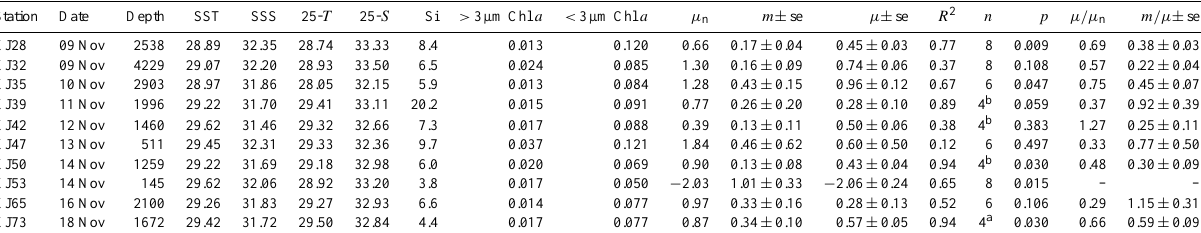
Table 2. Summary of environmental variables, phytoplankton growth rates with ( µ n , d − 1 ) and without ( µ , d − 1 ) nutrient amendment, and microzooplankton grazing rates ( m , d − 1 ) in the southern South China Sea in November 2010. SST, surface seawater temperature ( ◦ C); SSS, surface seawater salinity; 25- T ( S ) seawater temperature (salinity) at 25m in depth; Si, silicate (µmolL − 1 ); Chl a , chlorophyll a (µgL − 1 ); n , the number of data points in the linear part; R 2 , the determination coefficient of the regression of the linear part; se, standard error; the superscript “a” denotes a saturated feeding response; the superscript “b” denotes a saturated-increased feeding response. The significant level ( p ) of regressions when saturated-increased feeding responses occurred was in some occasions > 0.05 owing to the few points included in the